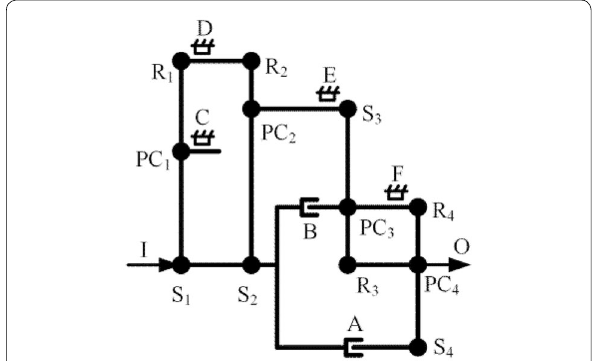
Figure 10 Equivalent lever diagram of the proposed AT mechanism (1)